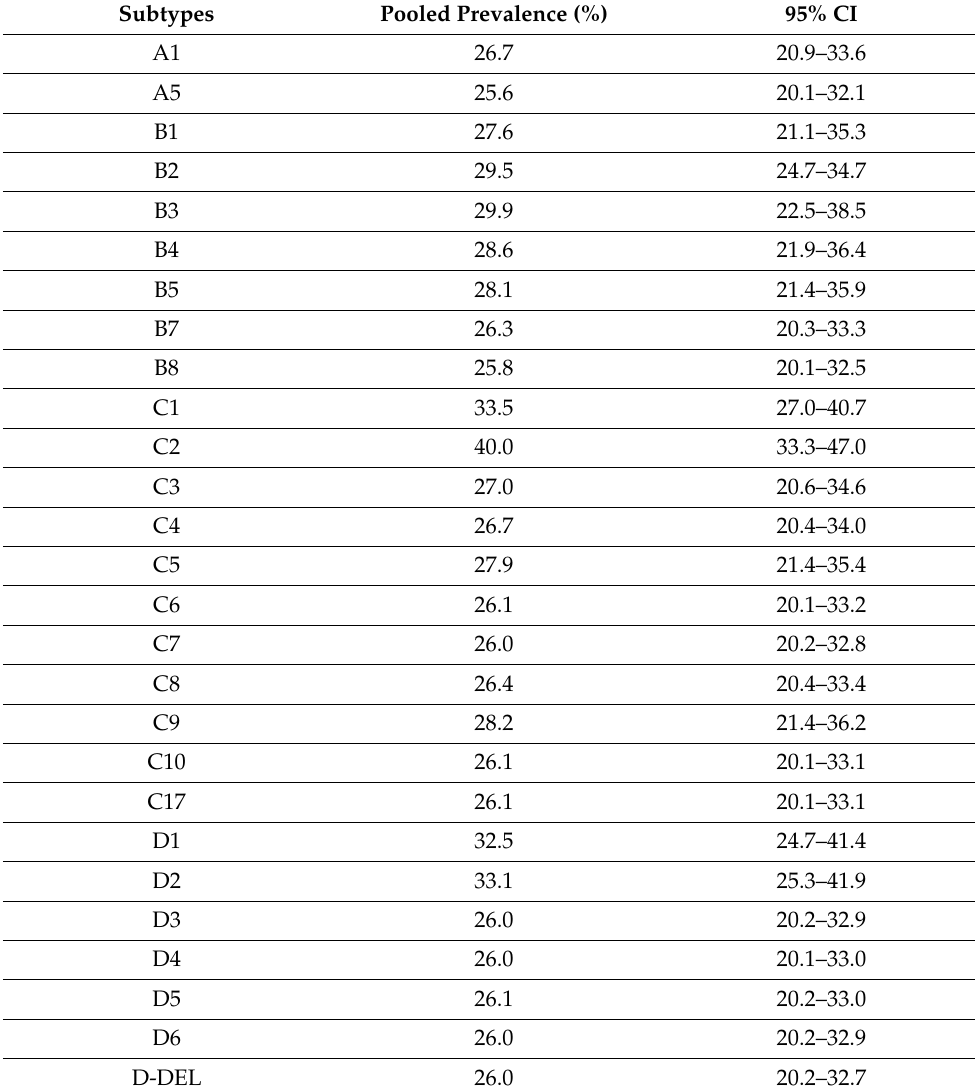
Table 1. Prevalence of HBV subtypes in